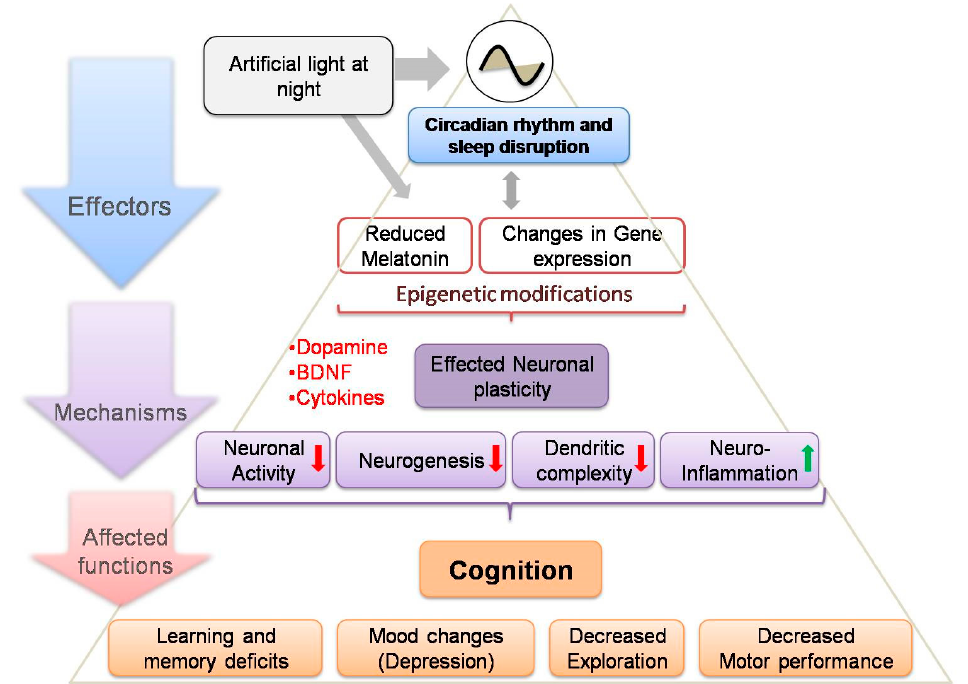
Figure 1. Schematic depicting effect of ALAN exposure, acting on different levels of organization (affecters) via a number of neuronal pathways (mechanisms), those resulting in a series of adverse effects on brain functions (affected functions). This model may help us to understand the complexity of the relationships among exposure components in a systematic manner and may help in assessing the impact on brain functions of ALAN exposure outcomes and their underlying mechanisms (red and green arrows indicate decreased and increased functions, respectively). BDNF: Brain derived neurotropic factor.